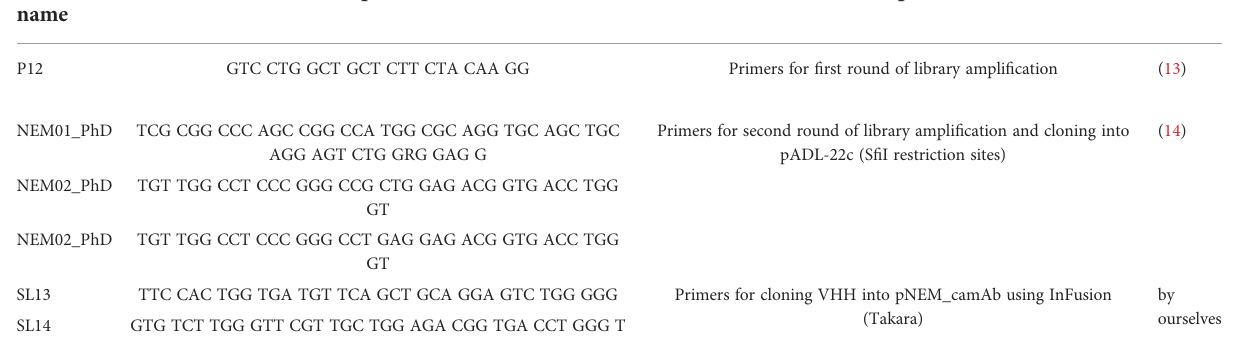
TABLE 1 Primer sequences for ampli fi cation of VHH sequences and